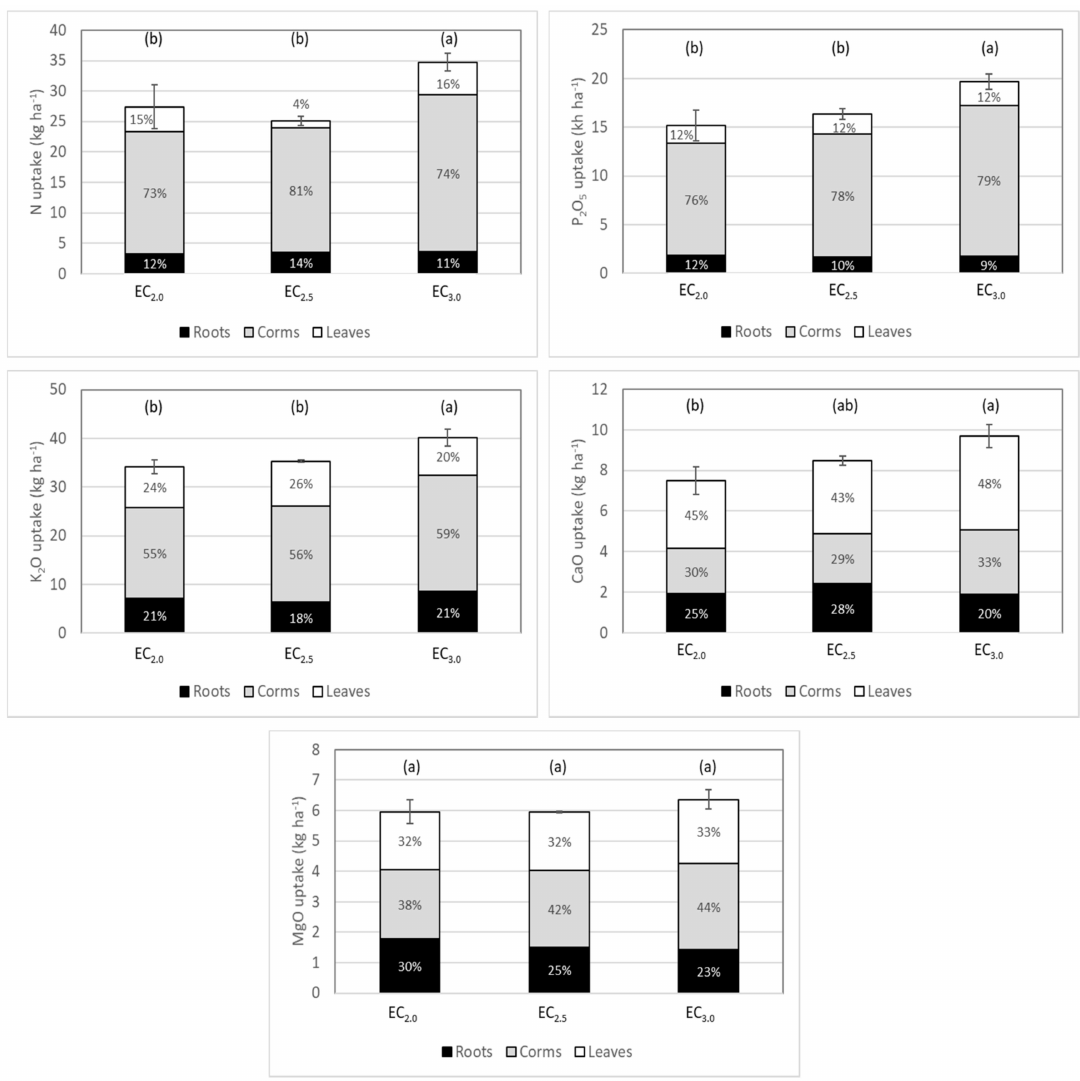
Figure 2. Total nutrient uptake (kg · ha − 1 ) and distribution of nutrients (%) in plant tissues (leaves, corms and roots) of sa ff ron grown in perlite fertigated with nutrient solutions at three EC levels 2.0, 2.5 and 3.0 dS · m − 1 . Di ff erent letters indicate significant di ff erences between treatments according to the LSD test ( p ≤